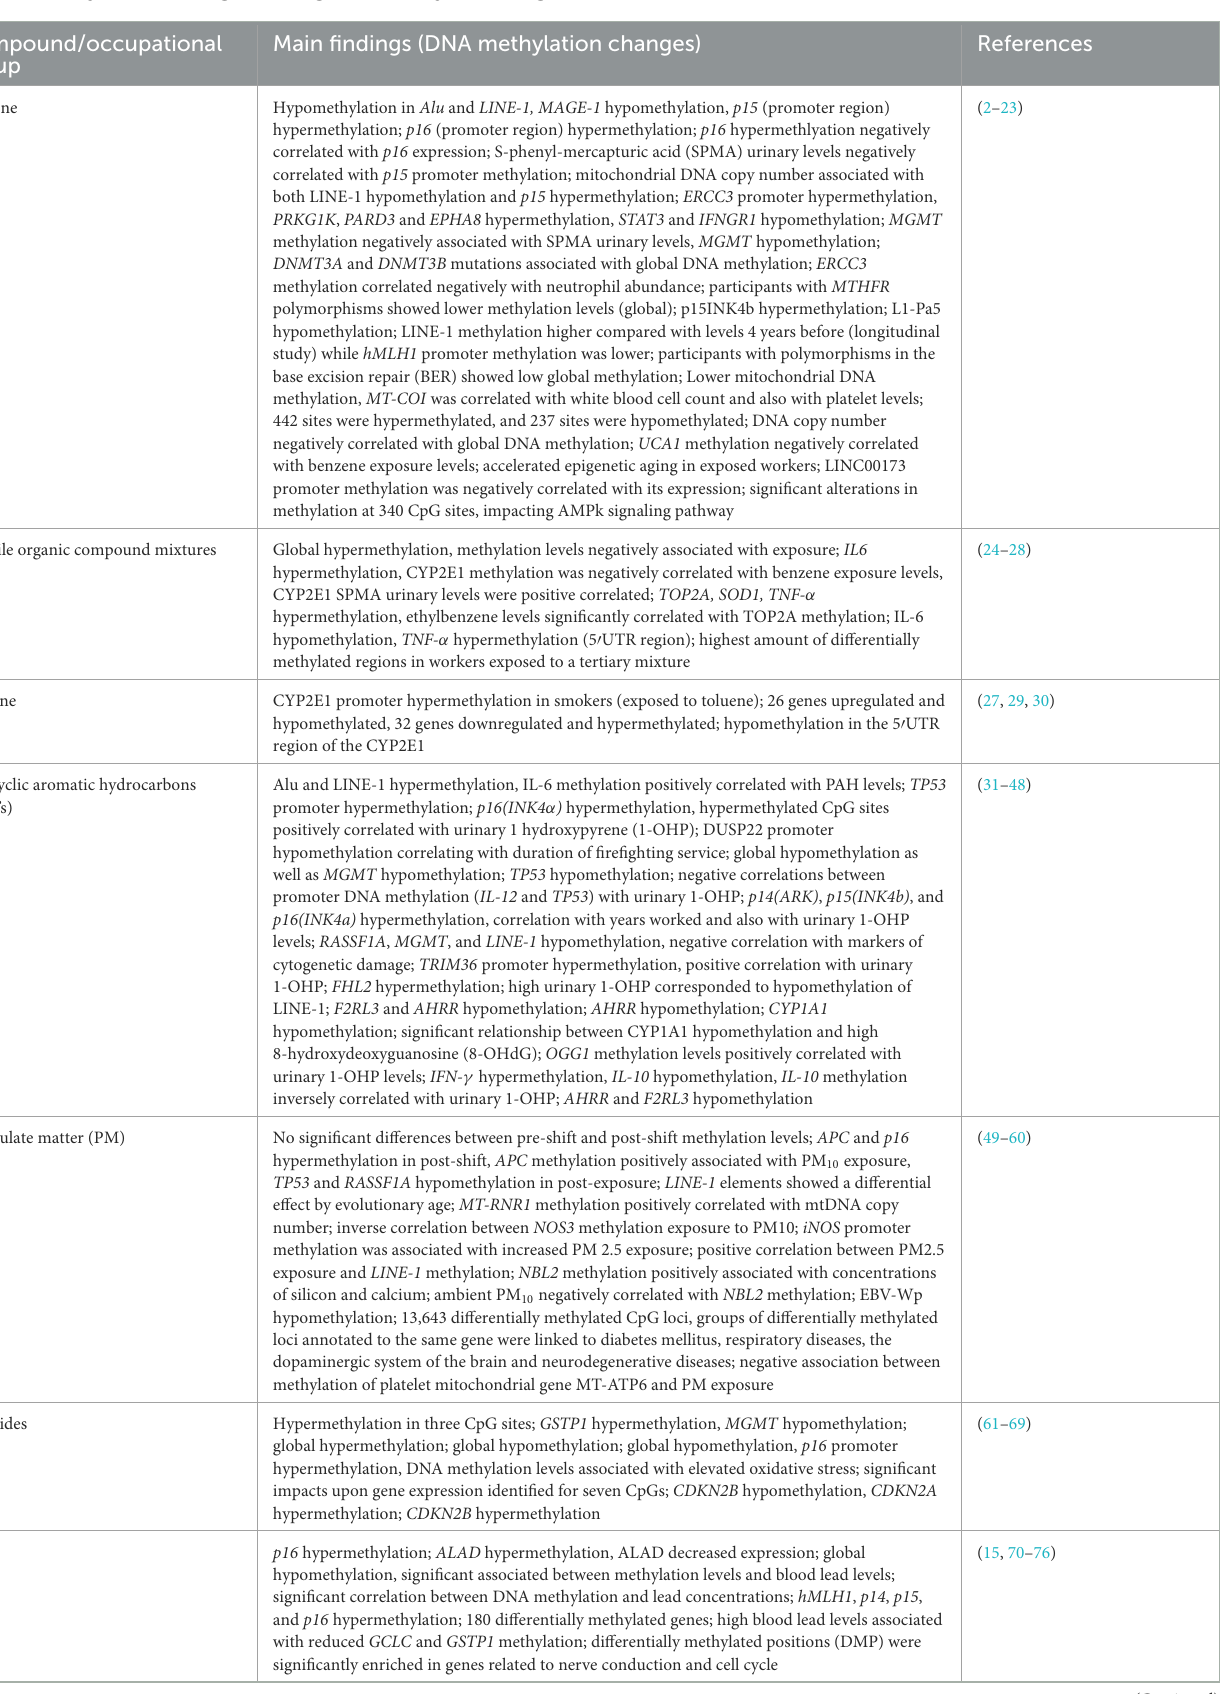
TABLE 2 Summary of mean findings according to DNA methylation changes ∗